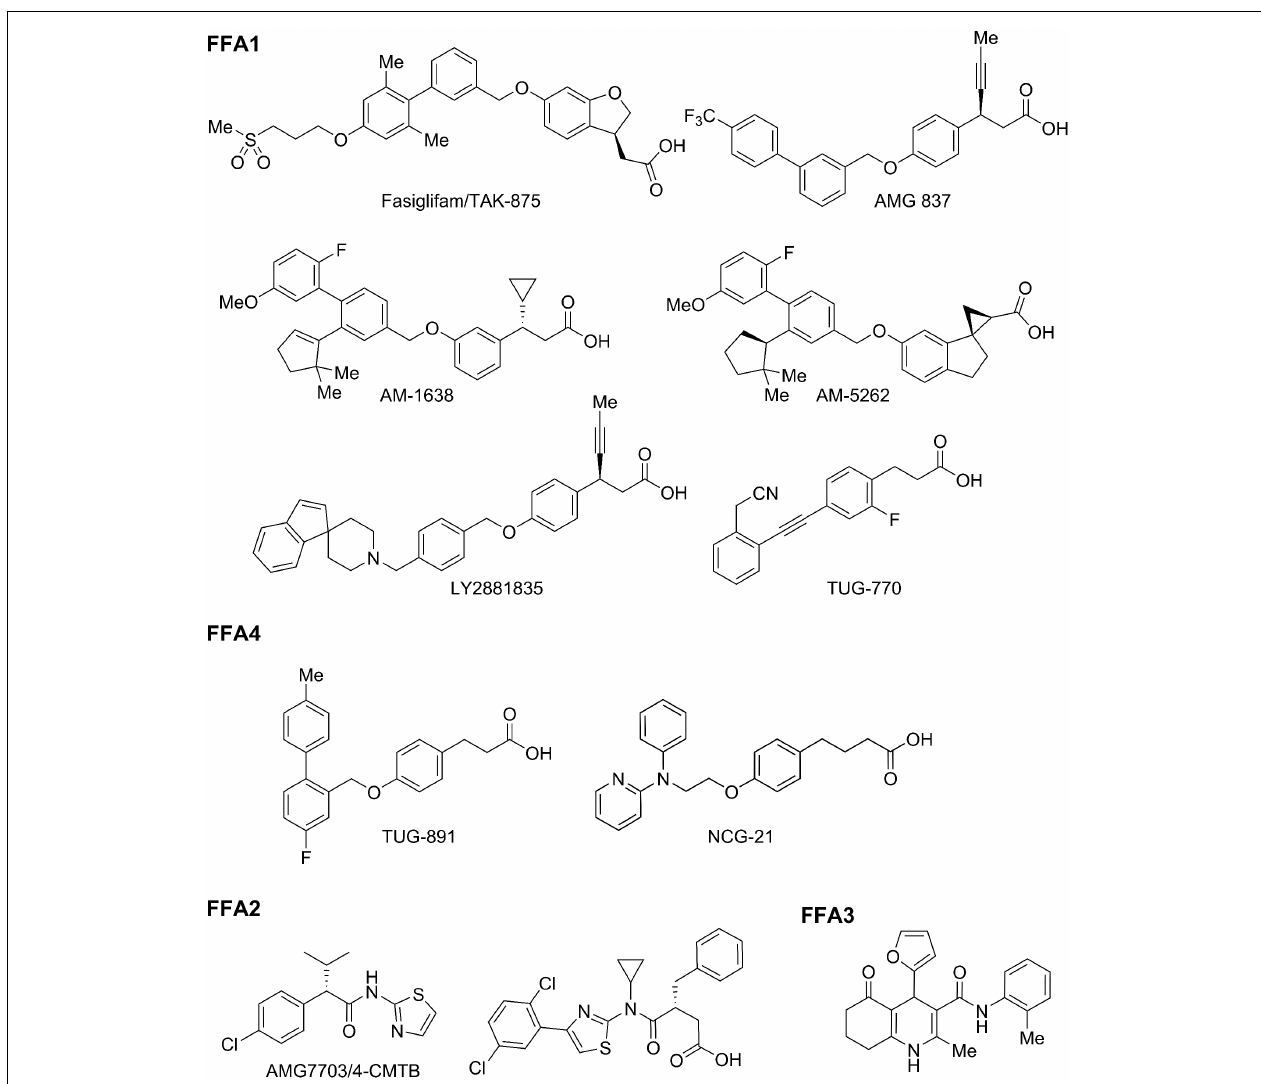
FIGURE 2 | Representative free fatty acid receptor agonists . A number of academic and industrial drug programs are aimed at developing FFA receptor agonists for the treatment ofT2D. A representative selection of the current range of synthetic agonists that have so far been developed for these receptors are